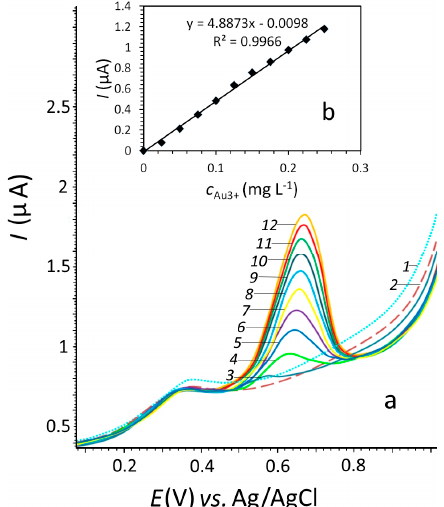
Figure 6. Anodic current–voltage curves ( a ) and calibration dependences ( b ) of gold determination from the surface of a GE modified by tosylate ions. Experimental conditions: medium of 1 mol L − 1 HCl; E e = − 0.7 V, t e = 120 s, v = 0.06 V s − 1 ; c Au3+ (mg L − 1 ): (1) blank, (2) 20 µL of 1% tosylate diazonium, (3) 0.025, (4) 0.05, (5) 0.075, (6) 0.1, (7) 0.125, (8) 0.15, (9) 0.175, (10) 0.2, (11) 0.225, and (12) 0.25.